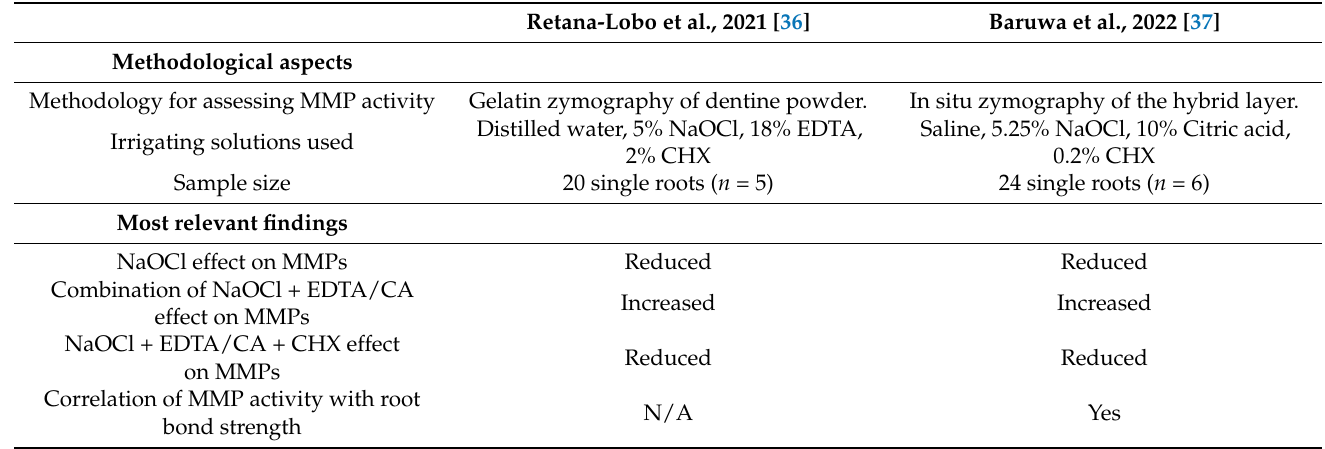
Table 2. Most relevant methodological aspects and relevant findings on studies addressing the MMP activity after root dentin exposition to irrigating solution. Retana-Lobo et al., 2021